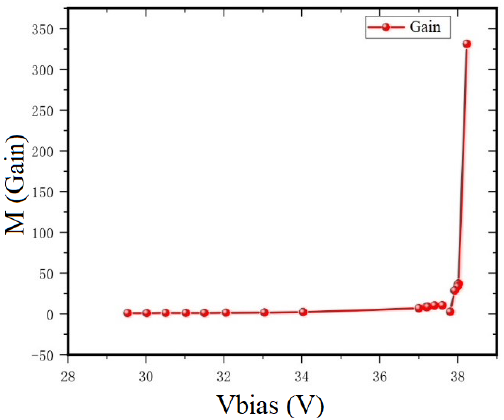
Figure 12. The gain curve of the device at 240 K as a function of bias voltage.